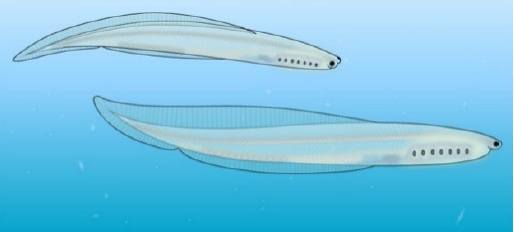
Figure 6. Zhongxiniscus . Length of animal 1 cm. PaleoArt credit: Cyrus Theedishman. Used here per CC BY-SA 3.0.